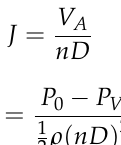
Table 2. Operating conditions for the INSEAN E779A propeller. Parameter Symbol and Unit Value Advance ratio J (-) 0.71 Rotation Rate n (rps) 36 Inflow averaged velocity V A (m/s) 5.8 Cavitation number σ (-) 1.763 Vapour pressure P V (Pa)